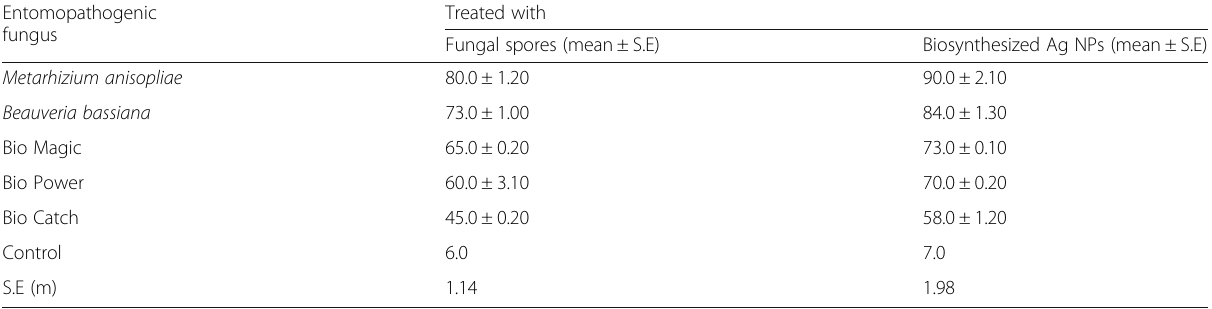
Table 1 Mortality percent of entomopathogenic fungi on the eggs of Rhynchophorus ferrugineus , using spore suspension and biosynthesized silver nano-particles Entomopathogenic fungus